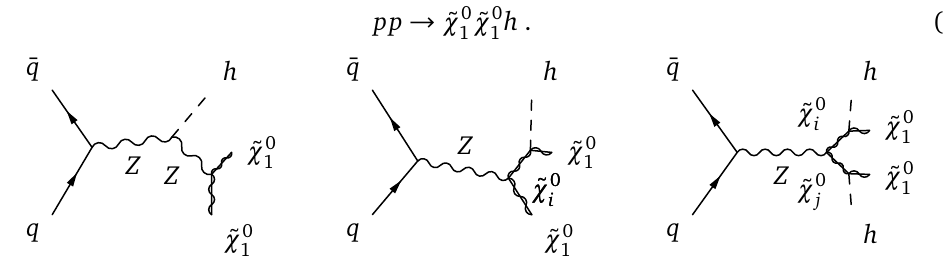
Figure 13: Feynman diagrams contributing to mono-Higgs production in the MSSM, Zh production with a Z -portal, and heavy neutralino decays, and Higgs pair produc-